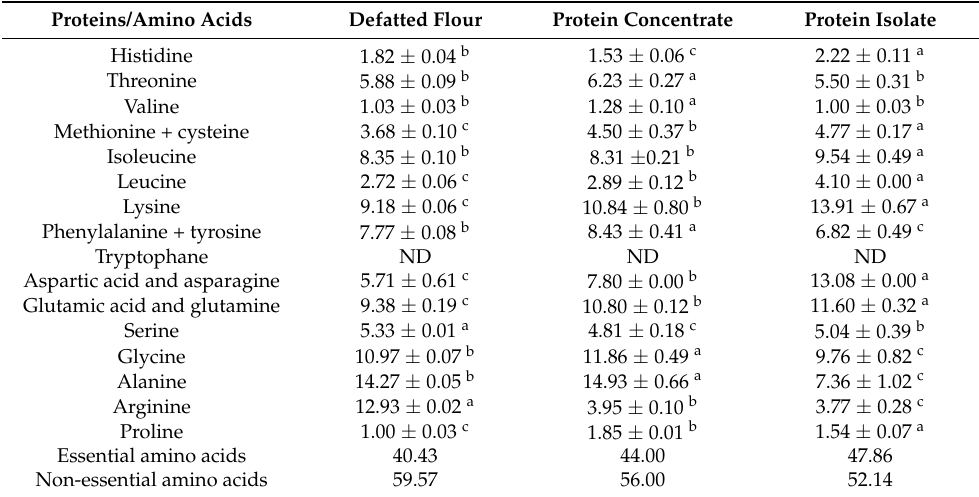
Table 5. Amino acid composition (g/100 g protein) of defatted flour, protein concentrate, and isolate of Brachytrupes membranaceus. Proteins/Amino Acids Defatted Flour Protein Concentrate Protein Isolate